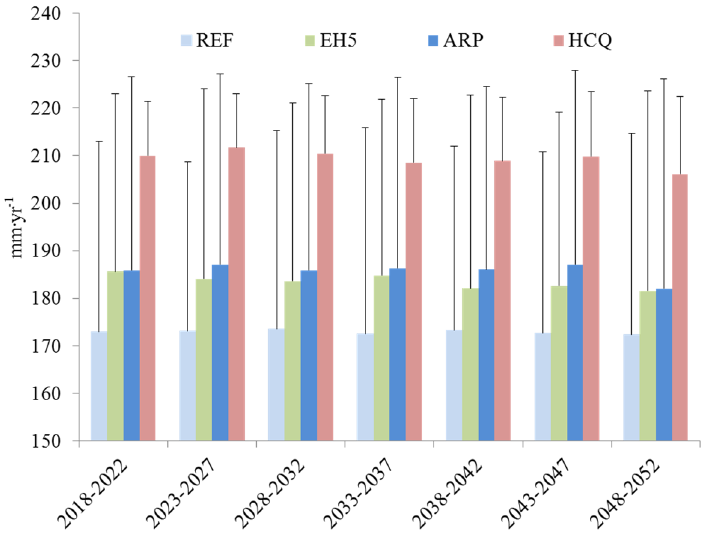
Figure 8. Five-year irrigation demand of potatoes on average (bars: medians) and in dry years (whiskers: 10th percentile) for multiple climate